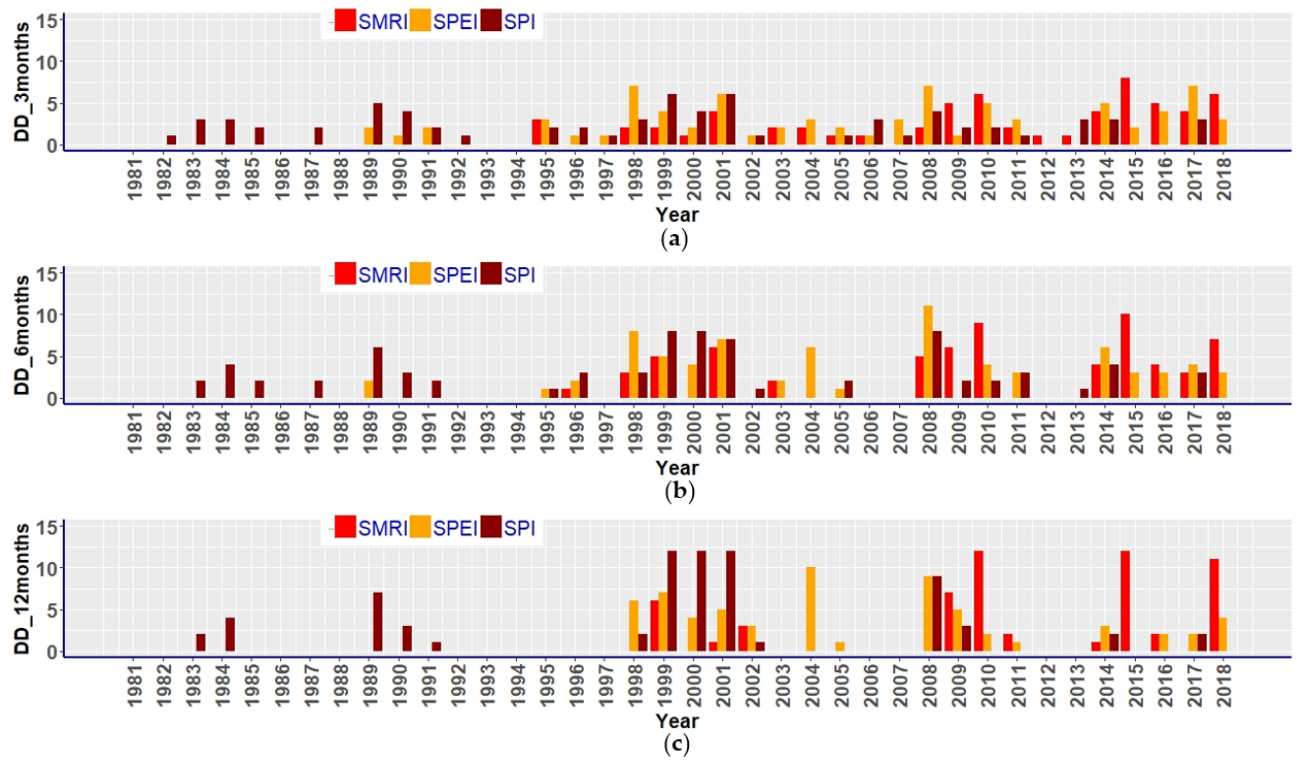
Figure 9. Drought Duration (DD) over ULB using SPI, SPEI and SMRI indices,1981 to 2018. ( a ) 3_months, ( b ) 6_months and ( c ) 12_ months.